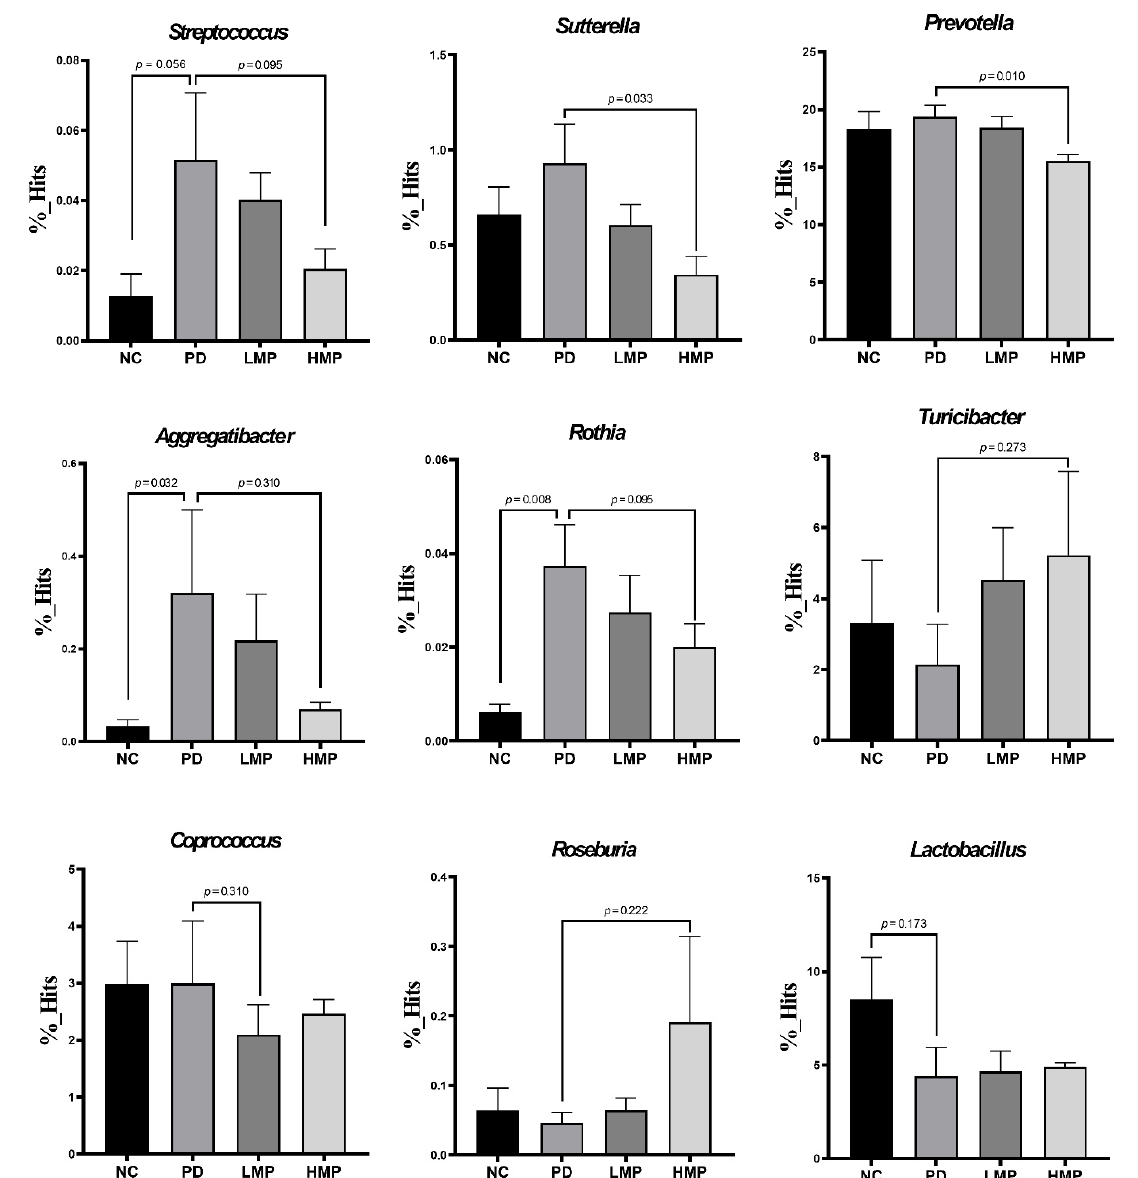
Figure 8. Analysis of the abundance of specific bacteria at the genus level after 8 weeks of supple- mentation in the low-dose mangosteen pericarp (LMP) and high-dose mangosteen pericarp (HMP). Results are average ± SEM for n = 5 rats/group and were analyzed using the unpaired t -test or Mann– Whitney test.